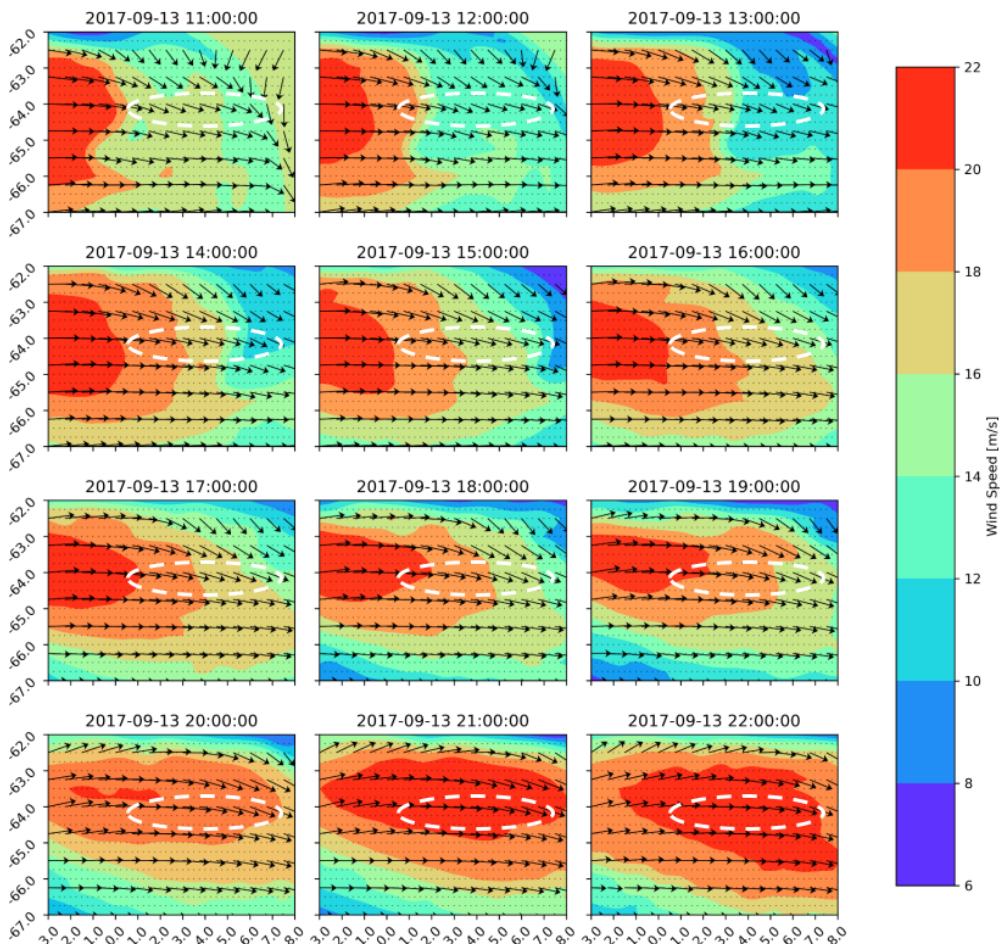
Figure 8. ERA5 quiver and contour plots of wind activity above Maud Rise for 9h on 13 September 2017, the day the 2017 Weddell Sea polynya rapidly expands. All times are reported as UTC. The polynya extent from 13 September 2017 is shown as a dashed white reference oval. All plots cover the area of interest outlined in Fig.